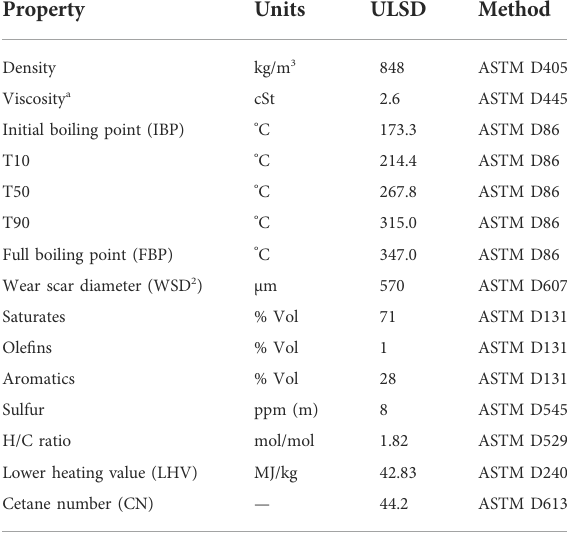
TABLE 3 Fuel properties (measured based on the sample fuel from Haltermann solutions).